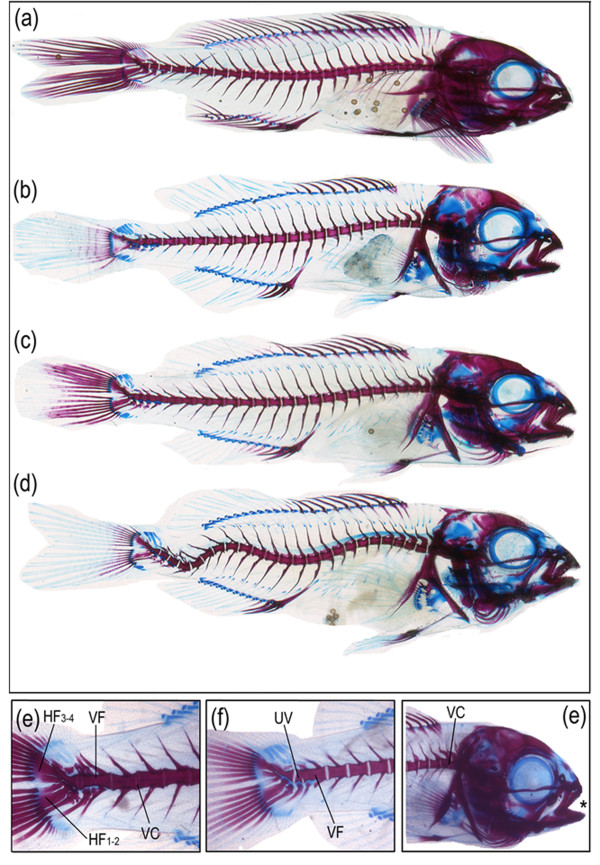
Examples of double stained fish with alcian blue/alizarin red from different dietary treatments showing different levels of ossifications and typologies of skeletal deformities. (a) Larva fed with control diet (0.66*108 total VA IU kg-1 DW) exhibiting mostly red coloured skeletal structures (calcified bone) with the exception of pterygiophores and sclerotic elements still stained with alcian blue (cartilage). (b) Larva fed moderately increased levels of VA (1.5×VA group, 1.00*108 total VA IU kg-1 DW) showing a larger proportion of skeletal structures stained in blue (cartilage) in comparison to the control group; e.g. pectoral fin girdle, epurals, parahypural and specialized neural arch in the caudal fin complex, and frontal, pterotic and parietal bones in the cranium. (c) Larva fed with the highest levels of VA (10×VA group, 6.82*108 total VA IU kg-1 DW) showing intermediate values in blue colouration with regards to the control group. The skeletal structures stained in blue (cartilage) are those already reported in the larva from the 1.5×VA group. (d) Larva showing a severe deformity (double lordosis and kyphosis) affecting haemal vertebrae. (e) Deformed caudal fin complex showing the fusion of the hypurals 3-4 (HF3-4) and 1-2 (HF1-2), as well as the fusion (VF) and compression (VC) of different haemal vertebrae centra (23-24 and 22-23, respectively). (f) Fusion of vertebral bodies (VF) from haemal vertebrae number 22 and 23 and underdevelopment of vertebrae 24 (UV). (e) Head of a larva with a slight prognathism (asterisk) due to an underdevelopment of the premaxillar and maxillar bones, and vertebral compression (VC) between centra of prehaemal vertebrae number 2 and 3.